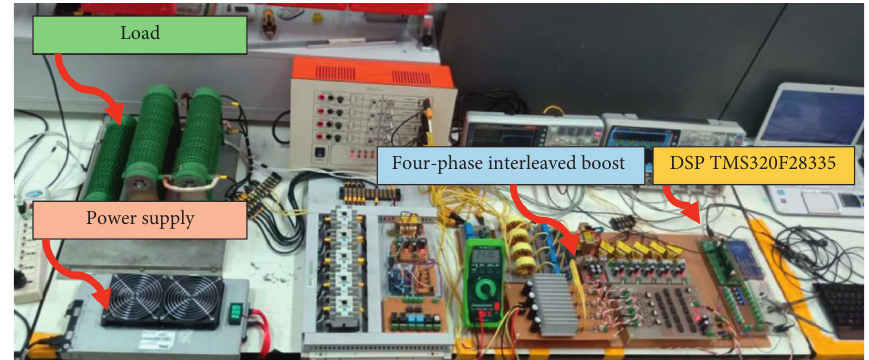
Figure 11: Shows the design of the PI controller using PSO for controlling Four-phase interleaved boost converter circuit voltage for the experiment.